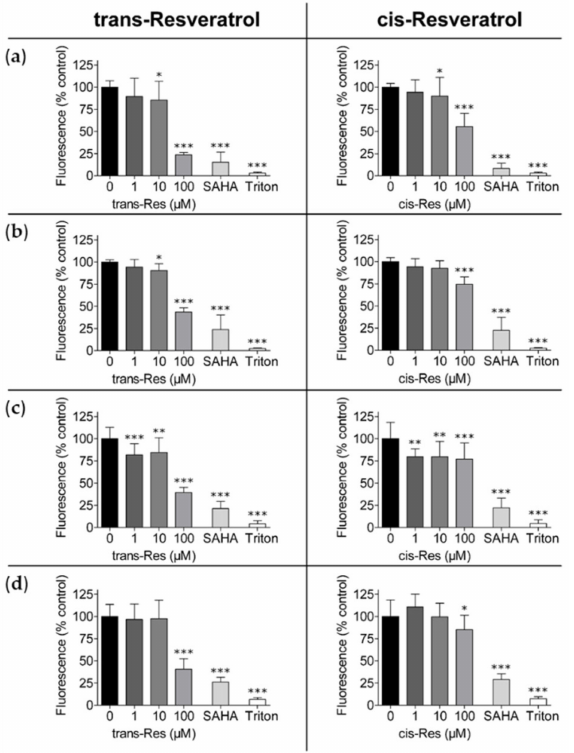
Figure 2. Reduced viability of hepatoma and colon carcinoma cells with different p53 status by trans- and cis-resveratrol shown by CTB assay. ( a ) HepG2, ( b ) Hep3B (hepatoma), ( c ) HCT-116, and ( d ) HCT-116/p53 ( − / − ) (colon carcinoma) cells were exposed to different concentrations of trans- and cis-resveratrol (1 µ M, 10 µ M, 100 µ M) for 72 h; 10 µ M SAHA served as positive control and 1% ( v / v ) Triton X-100 was added as a cell death control. The experiments were replicated in three independent experiments, each performed in pentaplicates. Results are shown as percentages compared to the untreated control. Error bars represent mean ± SD, statistical analysis with the Dunnet’s multiple comparison test, confidence interval 95%. *: p ≤ 0.05; **: p ≤ 0.01; ***: p ≤ 0.001. CTB, CellTiter Blue ® ; Res, resveratrol; SAHA, suberoylanilide hydroxamic